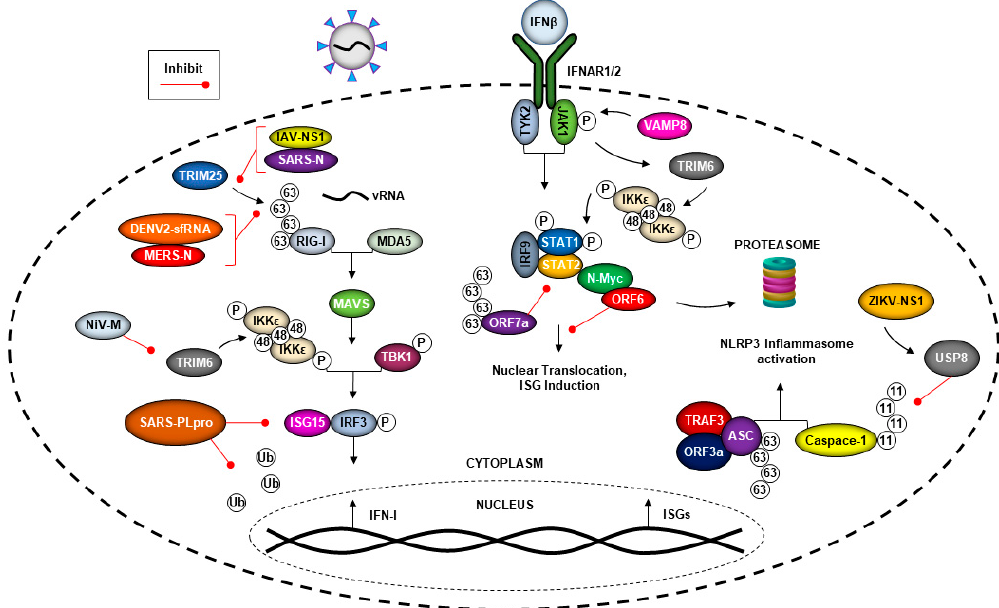
Figure 3. Viruses can evade immune responses utilizing the ubiquitin system. Viruses have evolved the ability to evade the host-innate immune response by antagonizing IFN production and signaling. SARS-CoV ORF6 can interact with N-Myc to promote its degradation through the ubiquitin proteasome, while ORF7a utilizes K63-linked polyubiquitin chains to prevent STAT2 phosphorylation and IFN-I signaling. The N protein of both SARS and MERS-CoV block the interaction between TRIM25 and RIG-I, preventing the K63-linked polyubiquitination of RIG-I needed for IFN-I production. TRIM25 is also a target of inhibition by the NS1 protein of IAV and the short noncoding sfRNAs of dengue-2 (DENV2). The PLpro component of SARS-CoV is capable of antagonizing innate immune pathways by acting as a deubiquitinase and by preventing the ISGylation of cellular proteins, including IRF3. Both SARS-CoV and Zika virus (ZIKV) alter components of the host ubiquitin system to activate the NLRP3 inflammasome, potentially leading to greater dissemination of viral progeny. The NS1 protein of ZIKV can recruit the deubiquitinase USP8 to cleave the K11-linked polyubiquitin chains from Caspase-1, while the SARS-CoV ORF3a protein promotes TRAF3 and ASC association, resulting in the K63-linked ubiquitination of ASC. In addition, ubiquitination also possesses antiviral functions. TRIM6 can regulate the expression of VAMP8 to promote JAK1 phosphorylation downstream of IFN-I signaling and promote the synthesis of unanchored K48-linked polyubiquitin chains for IKK ε